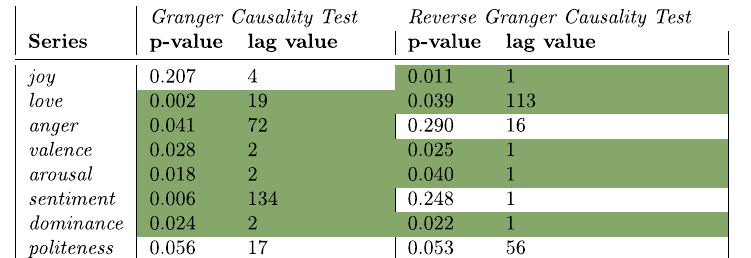
Table 5 Ethereum Granger Causality tests. Minimum observed p -values and corresponding lag values for different affect time series. We highlight in green the cases showing significant (direct or reverse) Granger causality